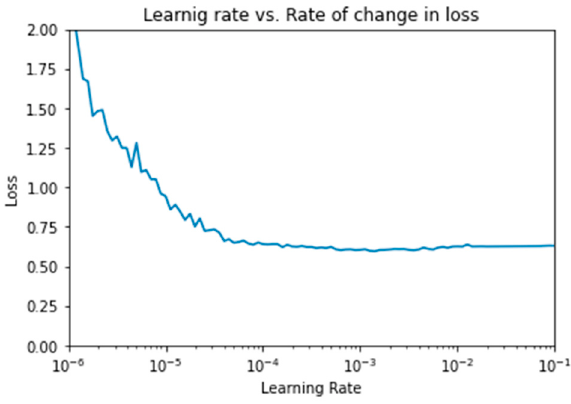
Figure 3. Optimized learning rate vs. changing in loss.